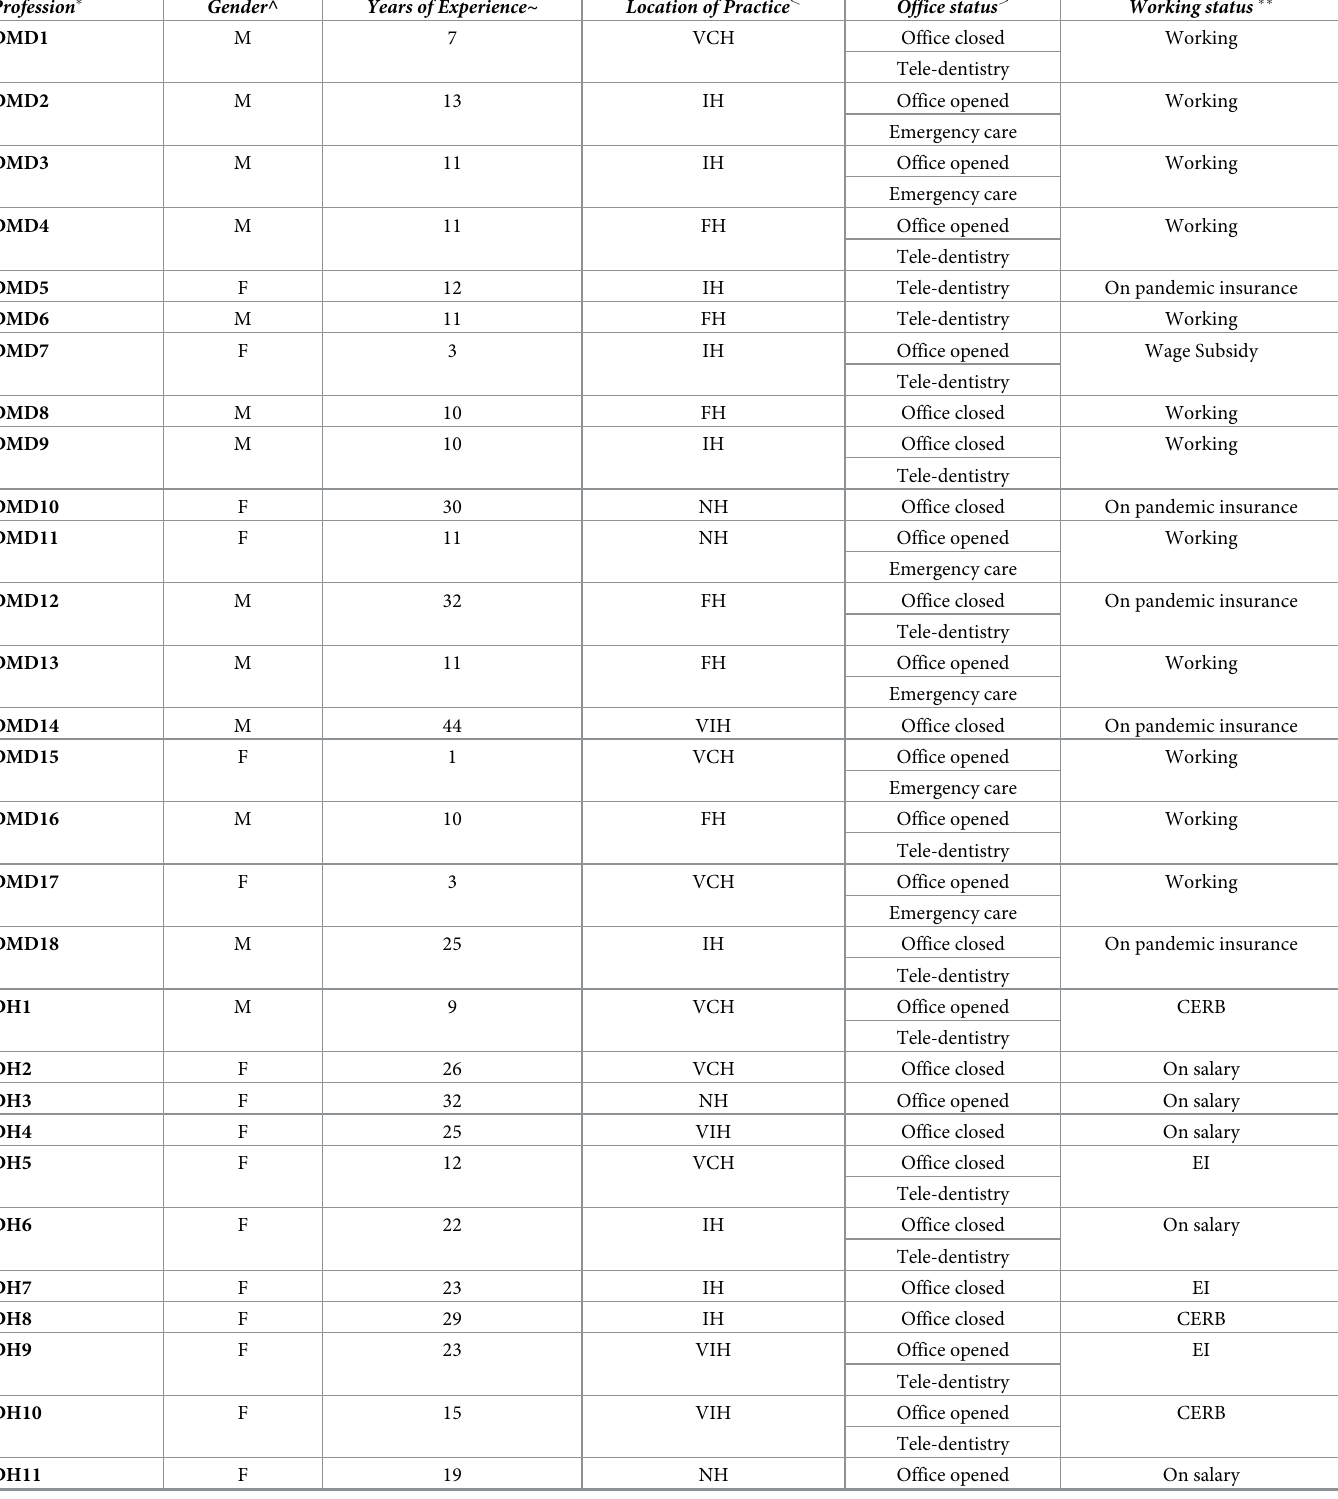
Table 1. Demographic information about the participants including profession, gender, years of experience, practice location, and working